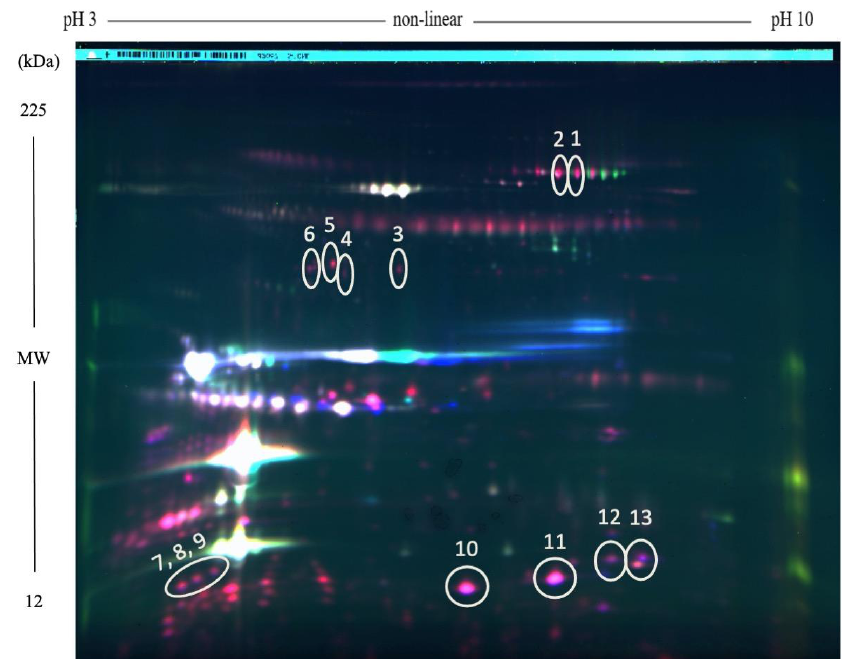
Figure 1. Proteomic analysis of milk whey proteins from healthy cows and cows with with S. aureus subclinical mastitis. Two-dimensional differential gel electrophoresis (2D-DIGE) composite image shows differentially-represented proteins in mastitic milk (red spots) compared to milk from healthy controls (green spots). Proteins with similar levels in both groups are represented by white spots. Gel spot numbers correspond to those indicated in Table